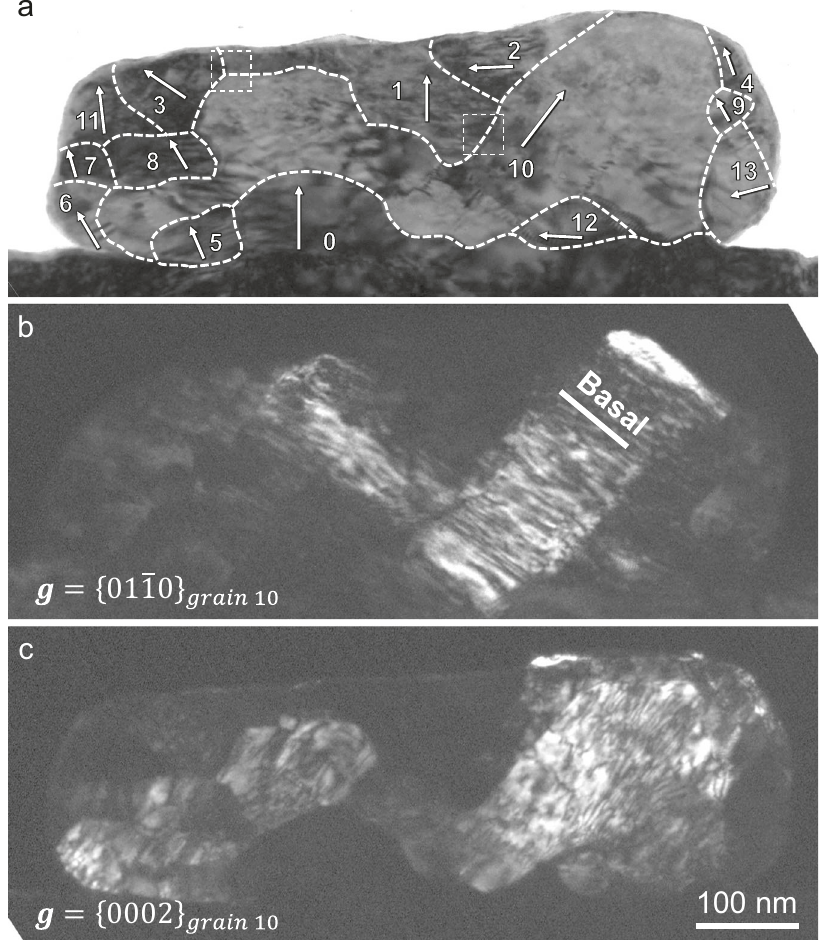
Fig. 2 The newly formed grains contain high-density dislocations. a The initial single crystal became 13 grains. The grain boundaries are outlined by white dashed lines. The white arrow indicates the c -axis of each grain. b High density basal dislocations in grain 10. When using g Burgers vector that contains h a i component are visible. These dislocations are found to generally follow the basal plane of grain 10 (marked by a white line), and they should be basal h a i dislocations. c High density of non-basal dislocations in grain 10. When using g that contains h c i component are visible. These dislocations are found to be out of basal plane, they should be non-basal h c i or h c þ a i dislocations. Viewing direction, (cid:2)h 2 (cid:1) 1 (cid:1) 10 i .